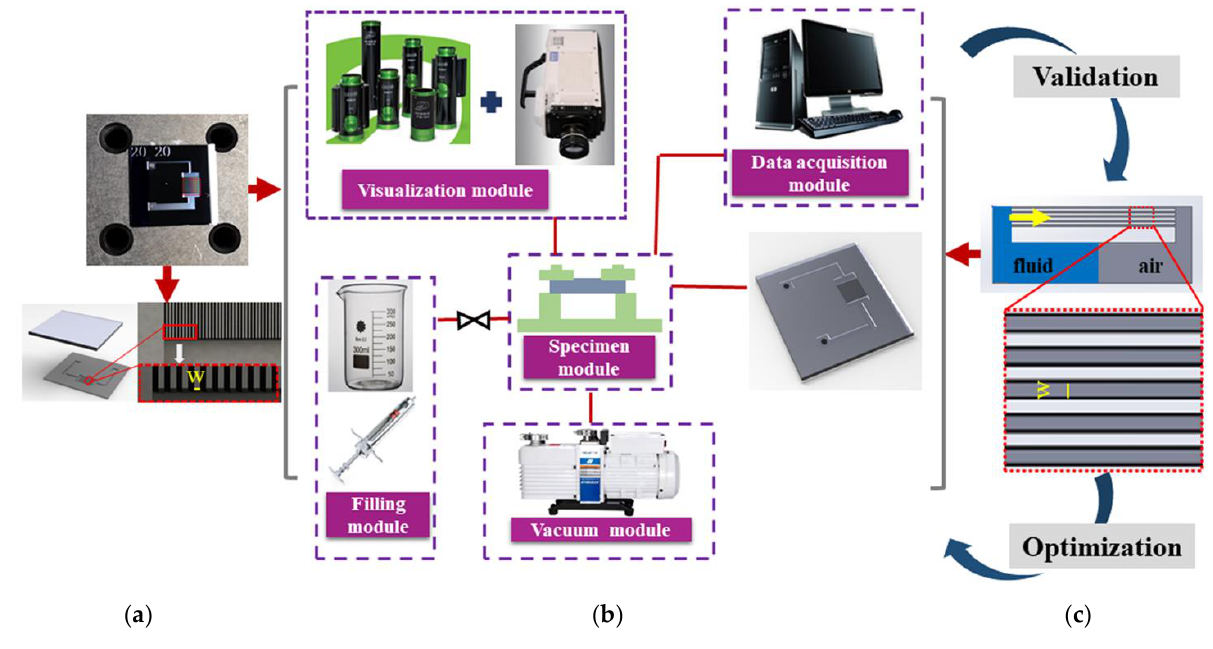
Figure 1. Framework of this research. ( a ) The physical map of the array microchannels; ( b ) The schematic diagram of the array microchannels capillary pumping experiment; and ( c ) The structure of the array microchannels simulation model.